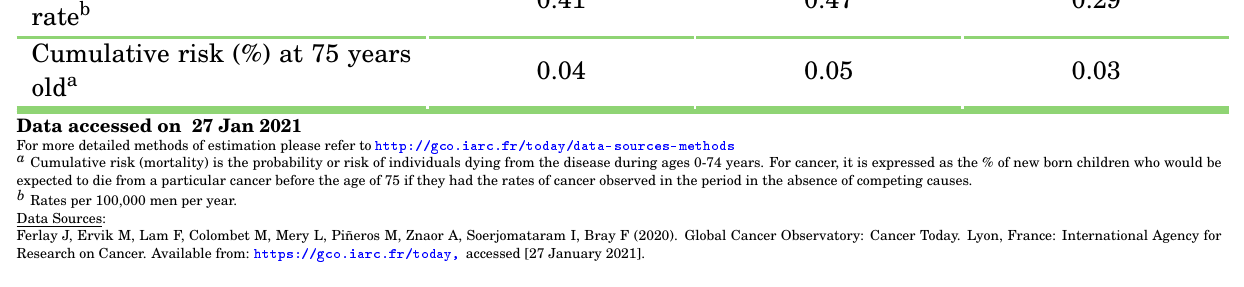
Table 14: Penile cancer mortality in Peru (estimates for 2020) Indicator Peru South America World Annual number of deaths 80 1,198 13,211 Uncertainty intervals [95% UI] [60-106] [1,062-1,351] [10,687-16,332] Crude mortality rate b 0.49 0.56 0.34 Age-standardized mortality 0.41 0.47 0.29 rate b Cumulative risk (%) at 75 years 0.04 0.05 old a